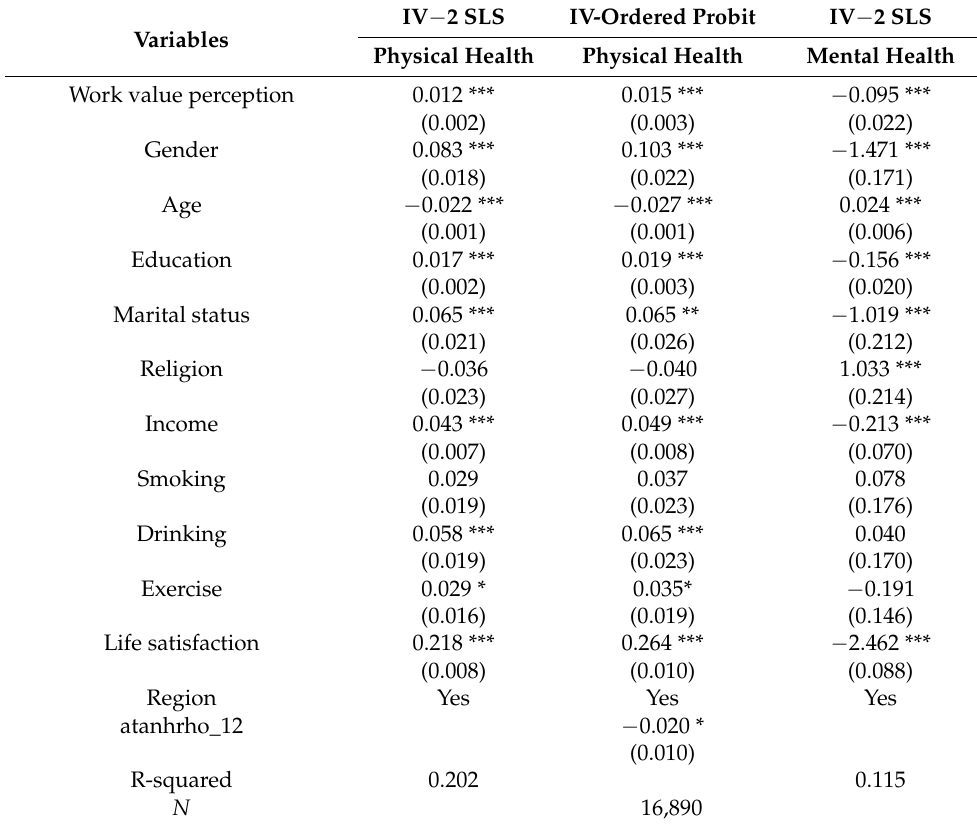
Table 3. Effects of work value perception on workers’ health (IV-ordered probit and IV − 2 SLS